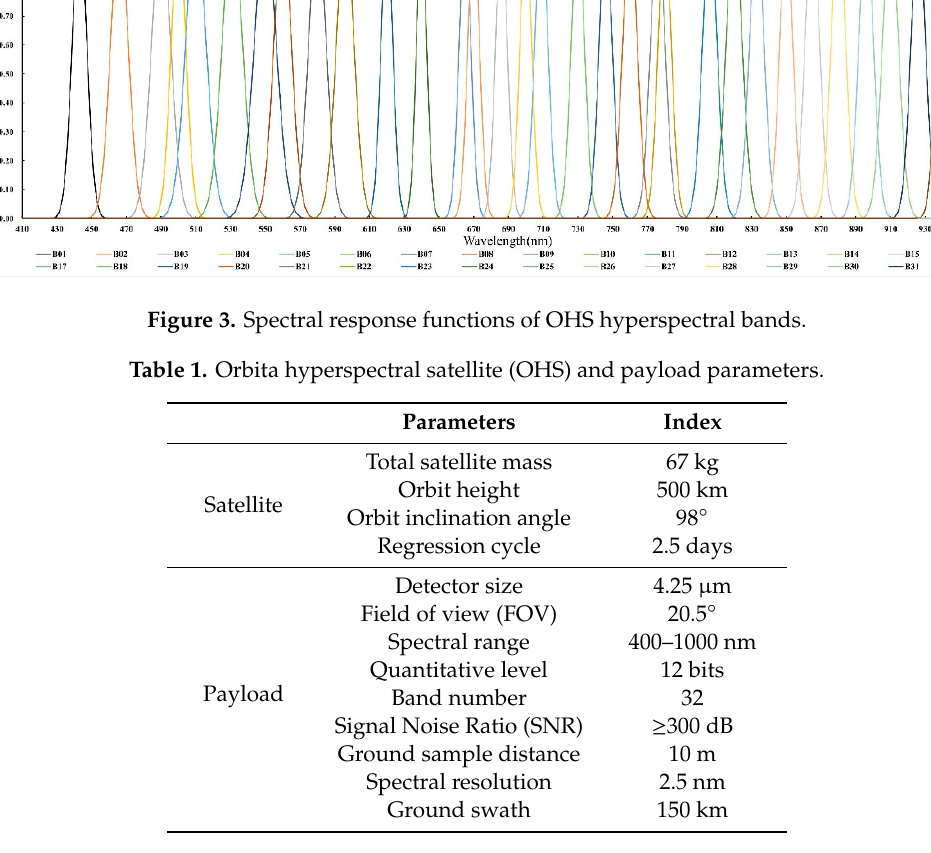
Table 2. Image registration experiment data. Name